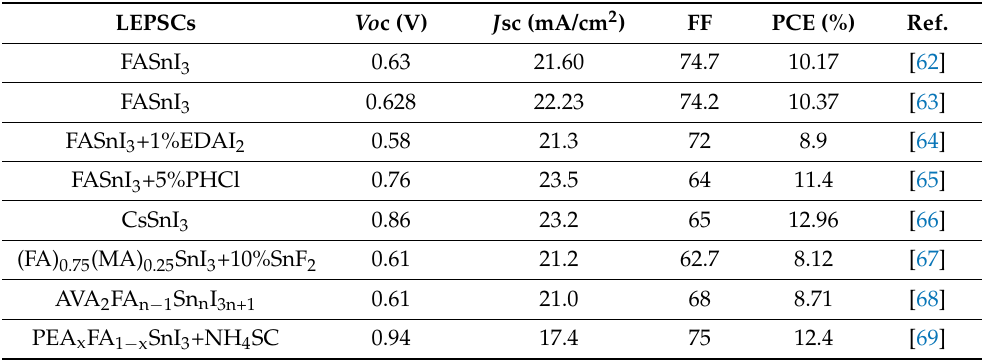
Table 3. Photovoltaic Parameters of LFPSCs based solar cells